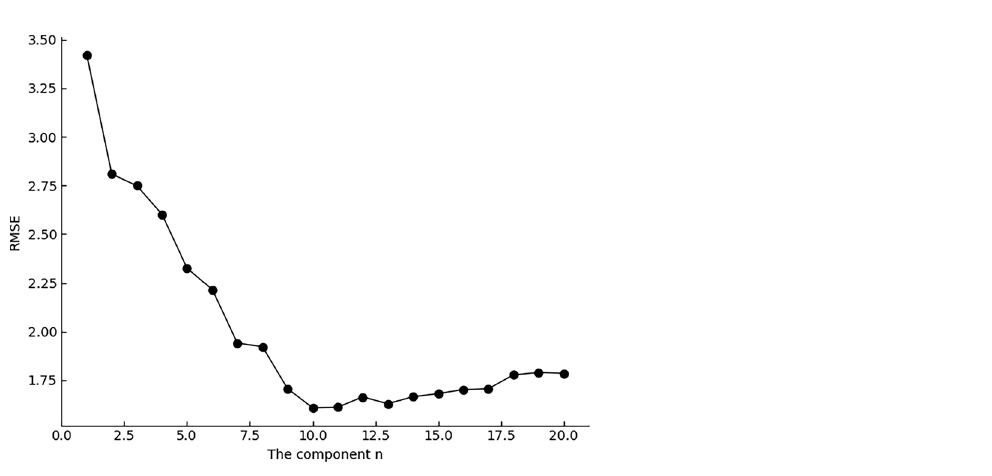
Figure 3. The average reflectance spectral curve of Grass1 ( a raw, b MS).